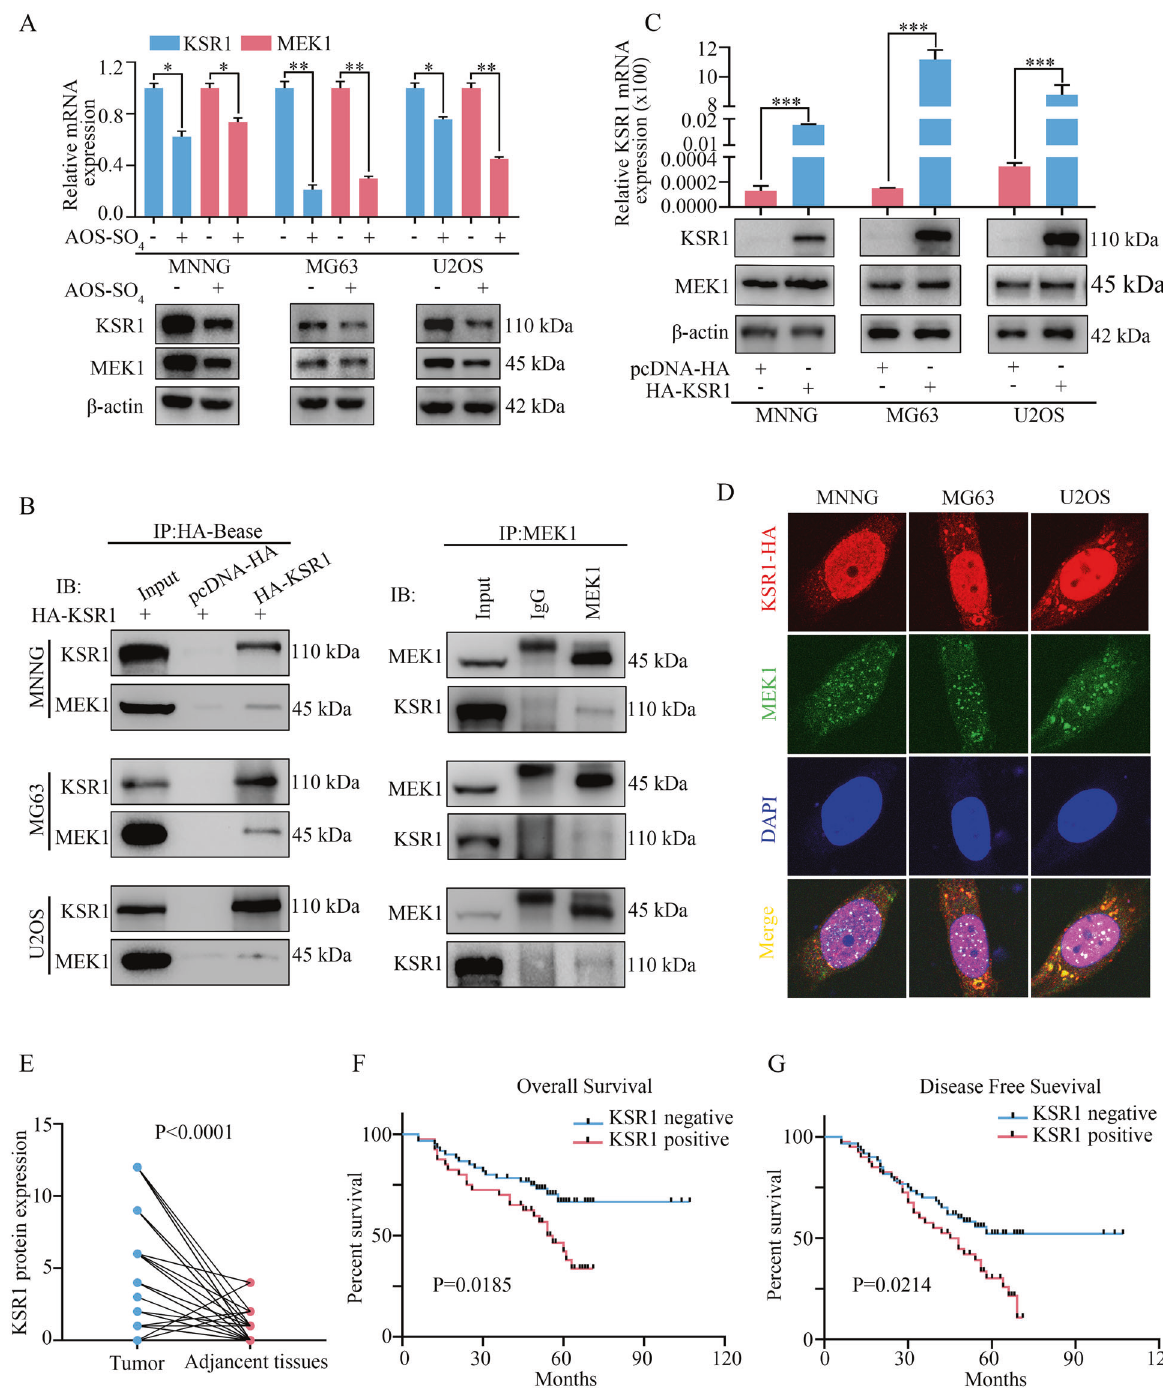
Fig. 7 KSR1 interacts with MEK1 in osteosarcoma cells and is a prognostic marker for osteosarcoma. A The relative mRNA and protein expression levels of KSR1 and MEK1 after treatment with AOS-SO 4 . B Immunoprecipitation was carried out using anti-HA antibody and anti- MEK1 antibody, and speci fi c associations between KSR1 and MEK1 were analyzed by western blot in osteosarcoma cells transfected with plasmids encoding HA-tagged KSR1. C The relative KSR1 mRNA expression and the KSR1 and MEK1 protein expression were detected after transfection with the pcDNA 3.1-HA-KSR1 plasmid. pcDNA 3.1-HA was used as a negative control. D Immuno fl uorescence analysis was performed using anti-HA and anti-MEK1 antibodies. DAPI was used as a control for nuclear staining. E KSR1 protein expression in 100 pairs of osteosarcoma tissues and adjacent nontumor tissues. F, G The effects of KSR1 expression level on overall survival and disease-free survival of patients with osteosarcoma. Data are shown as the means ± SD from at least three independent experiments. Statistical analysis was performed using Student ’ s t -test ( A, C, E ) and Log-rank test ( F, G ). Error bars represent the SEM. * P < 0.05, ** P < 0.01; *** P < 0.001.